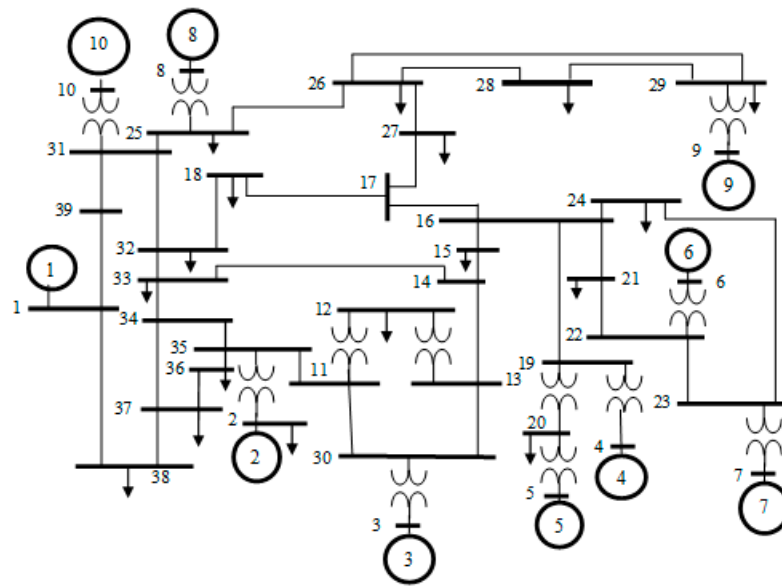
Figure 4. One-line diagram of the 10-unit